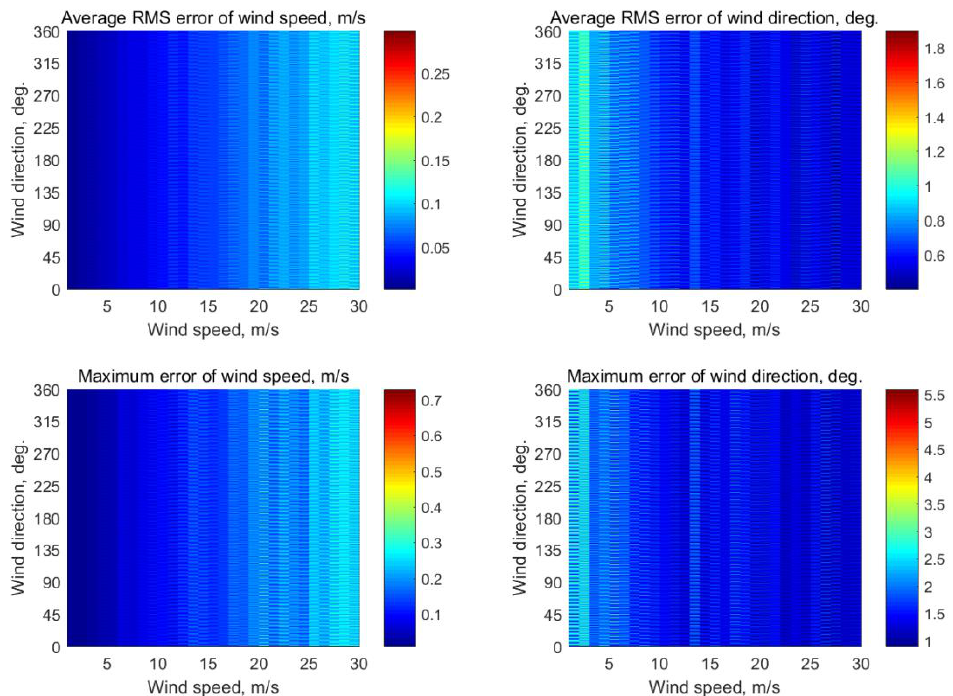
Figure A18. Simulation results of the use of three incidence angles of 50°, 55°, and 60° for wind retrieval.